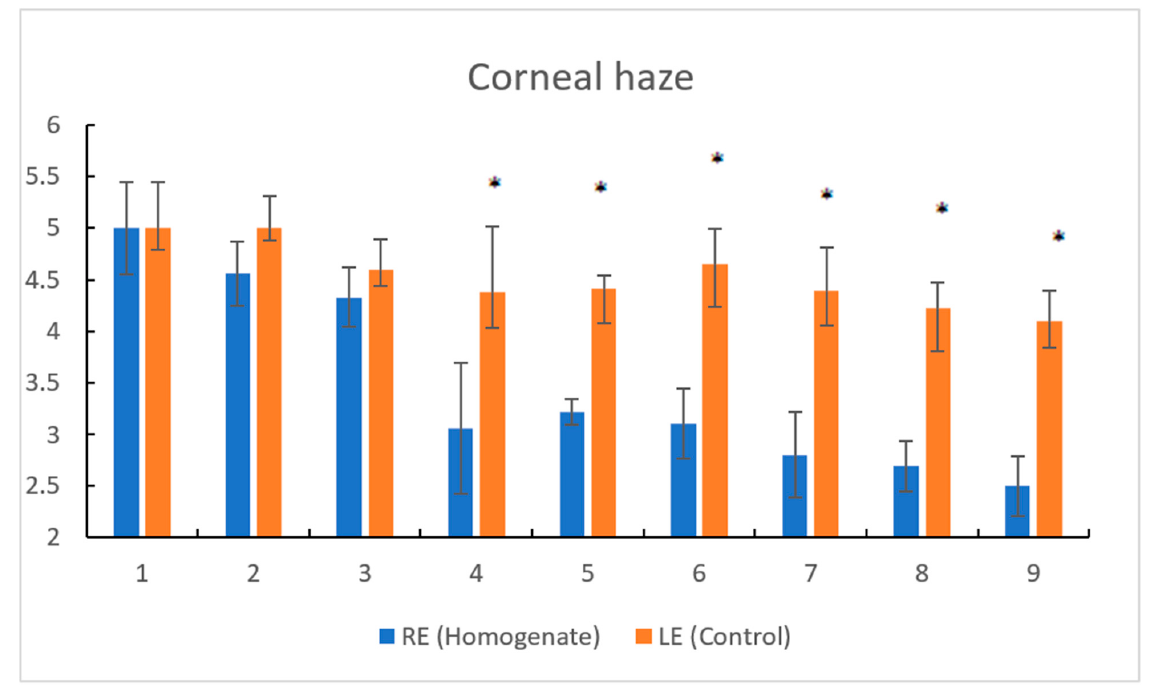
Figure 2. Corneal damage scores ( Y -axis) from the start of the experiment to week 9, on a 5-point scale (1—cornea completely clear and 5—cornea completely opaque) in the homogenate-treated group compared to the control. Observations were made at 9 weeks ( X -axis). RE—right eye and LE—left eye. *—statistically significant. Number of eyes: 24.